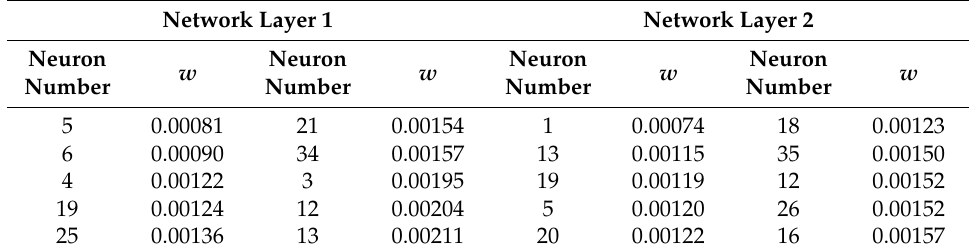
Table 3. w for neurons selected of each layer.